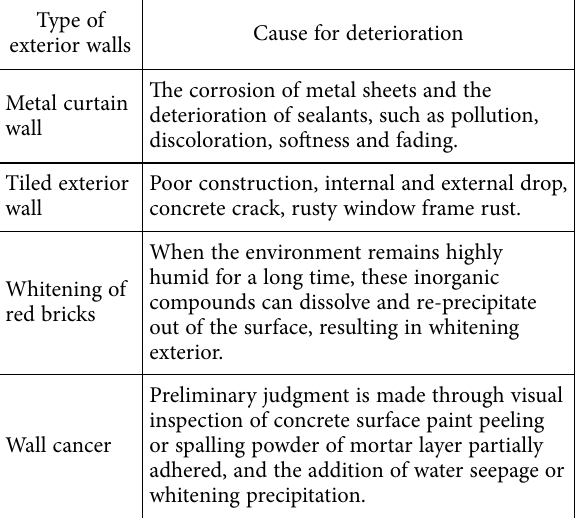
Cause for deterioration